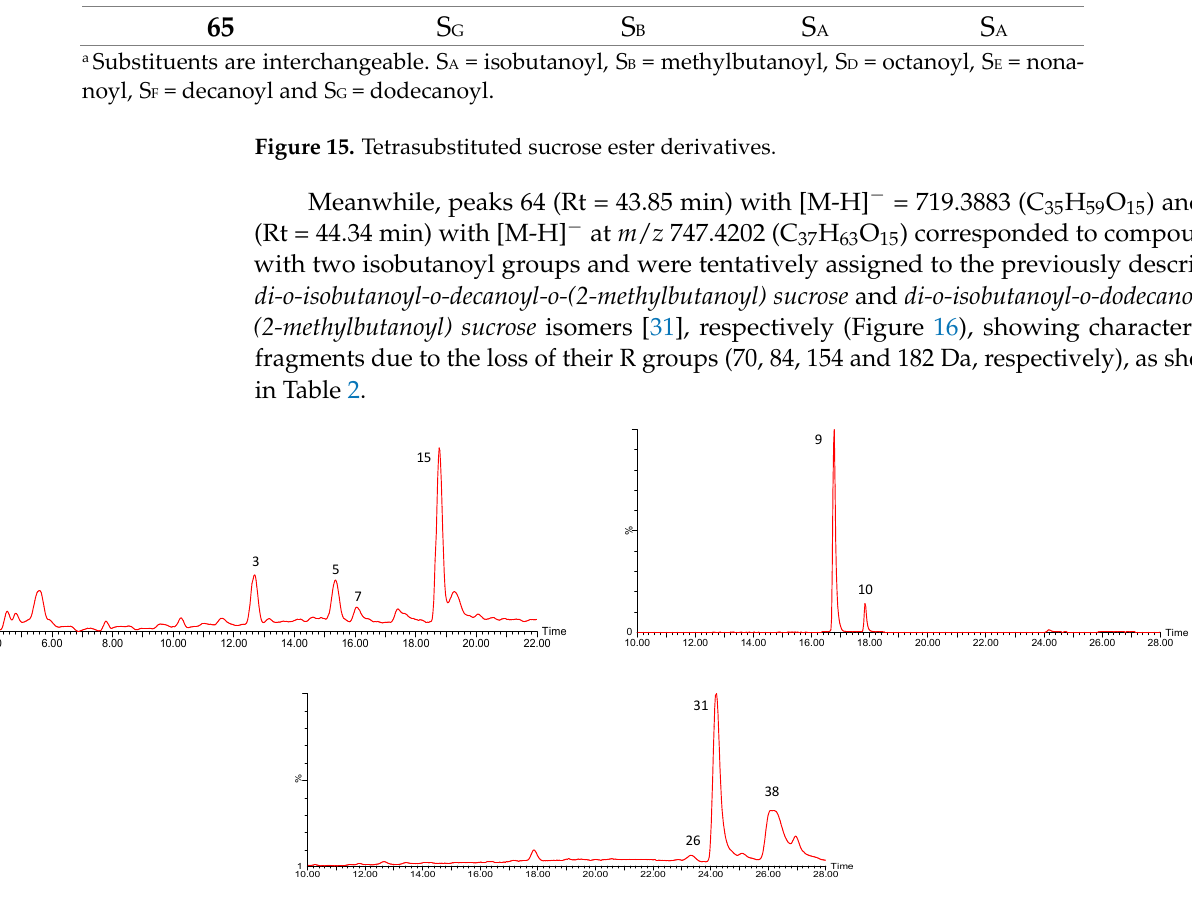
Figure 16. UPLC QTOF-ESI MS extracted ion chromatograms of flavonoids from P. peruviana husks and fruits.